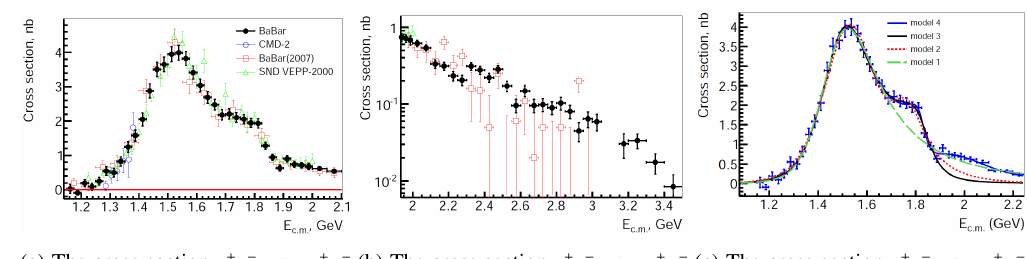
Figure 3: The cross section e + e − → ηπ + π −